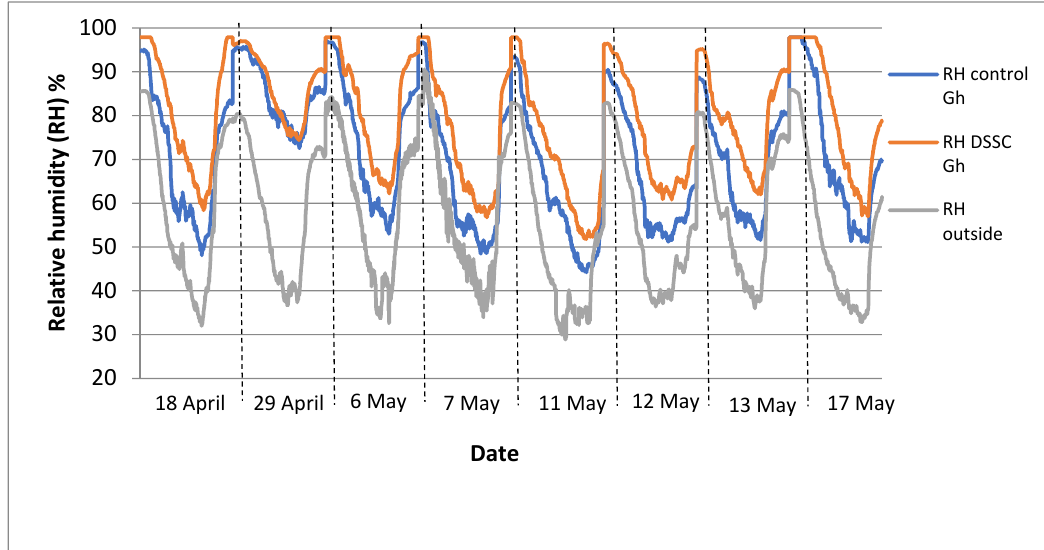
Figure 4. Relative humidity outside and inside greenhouses.